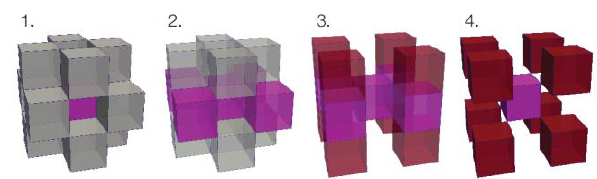
Figure 7: Face neighbours - First step: edge neighbours, second step: selected edge neighbours, third step: compute